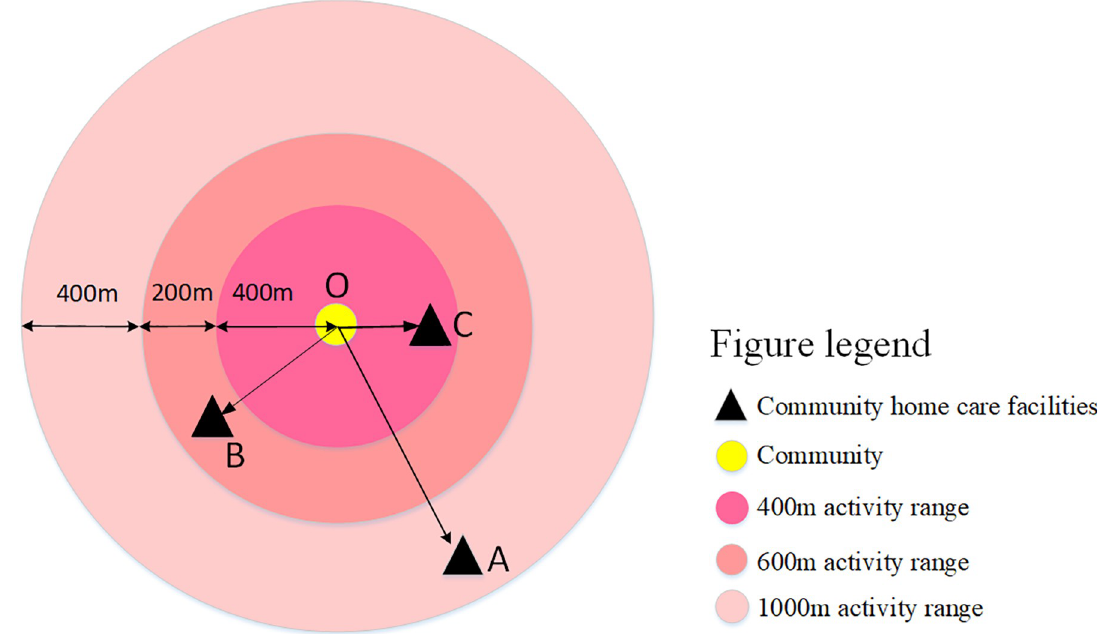
Fig 7. Diagram of the ability of elderly people with different mobility to access community home care facilities. (Self-drawn by the